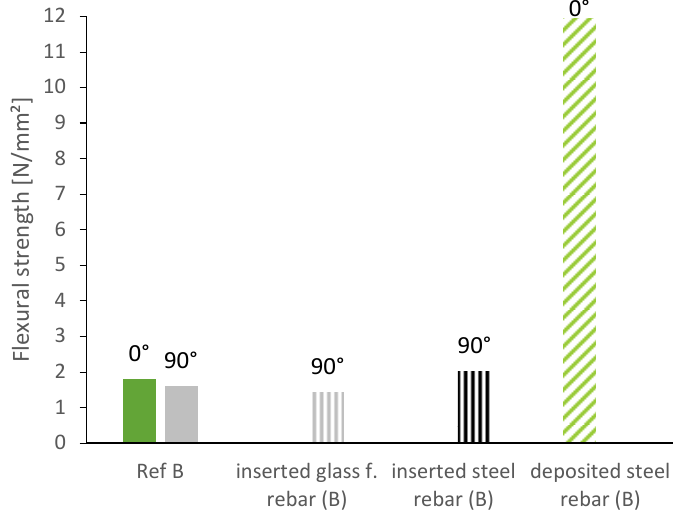
Figure 14. Flexural strength depending on the bond between the rebar (steel / glass fiber) and the mortar in comparison to flexural strength of the reference mixture.